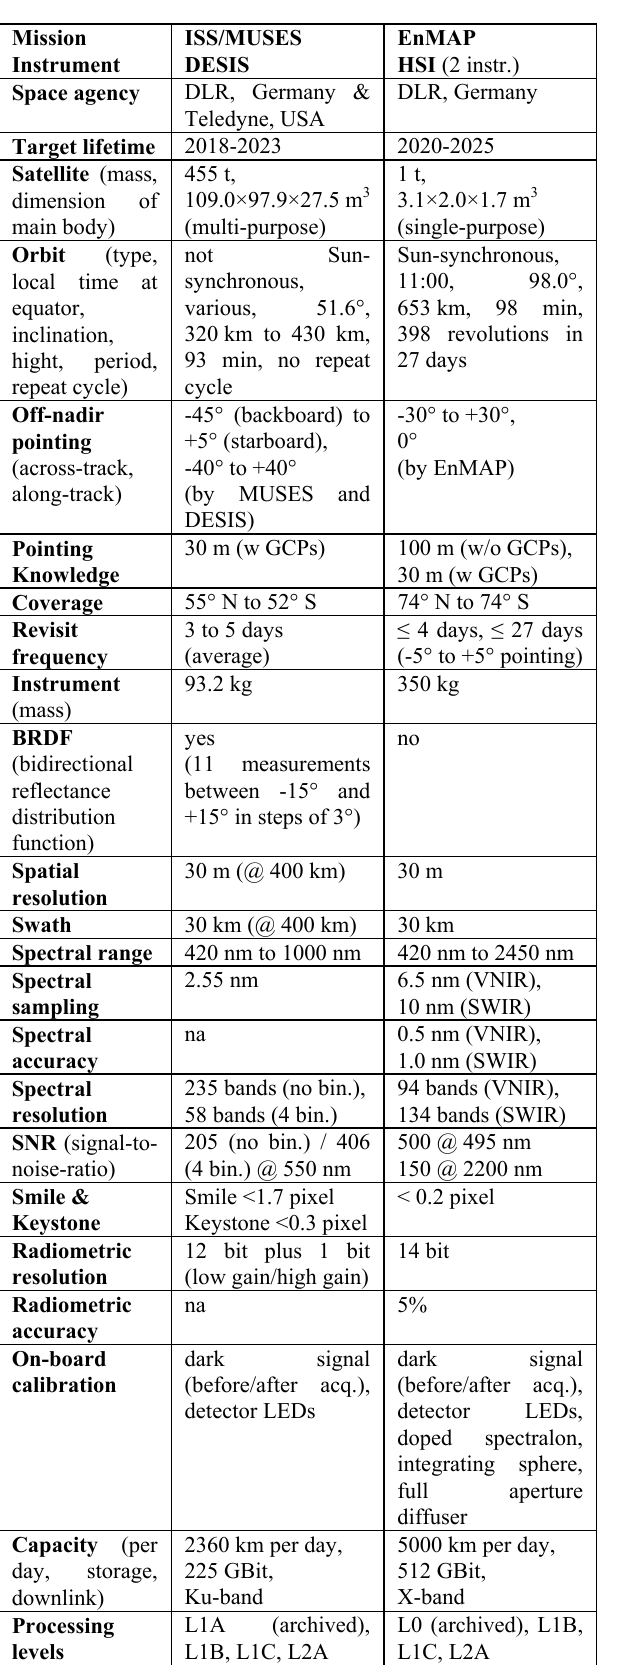
Table 1. DESIS vs. EnMAP